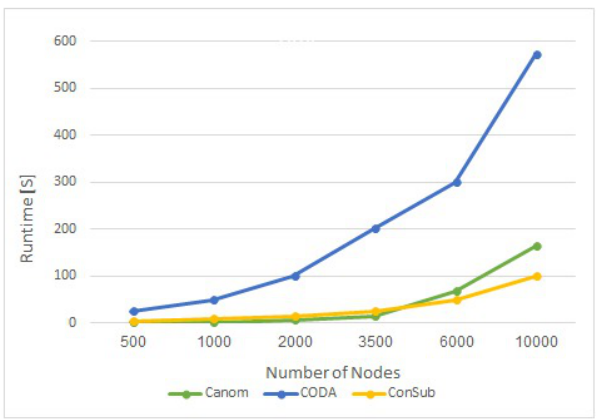
Figure 9. Variations in AUC according to the different number of nodes for each of the tested models.